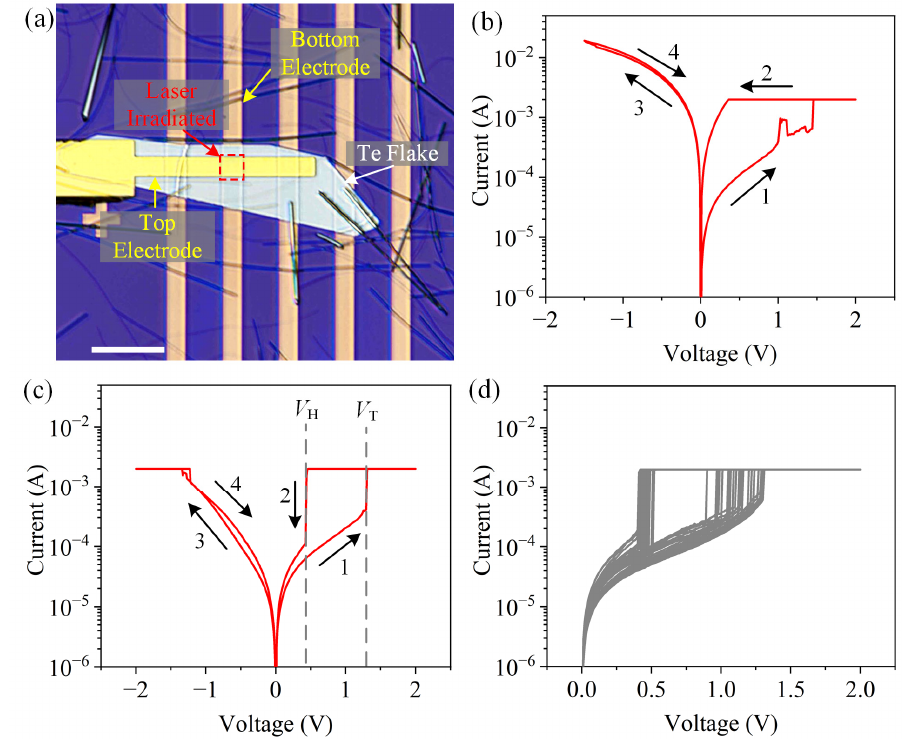
Figure 7. Volatile memristor based on laser-irradiated Te flake. ( a ) Optical image of two-terminal vertical nano-devices, scale bar is 20 μ m; typical I–V curves of devices based on pristine ( b ) and laser-irradiated flakes ( c ). The black arrows label the voltage sweep order. ( d ) The endurance test of 30 cycles.